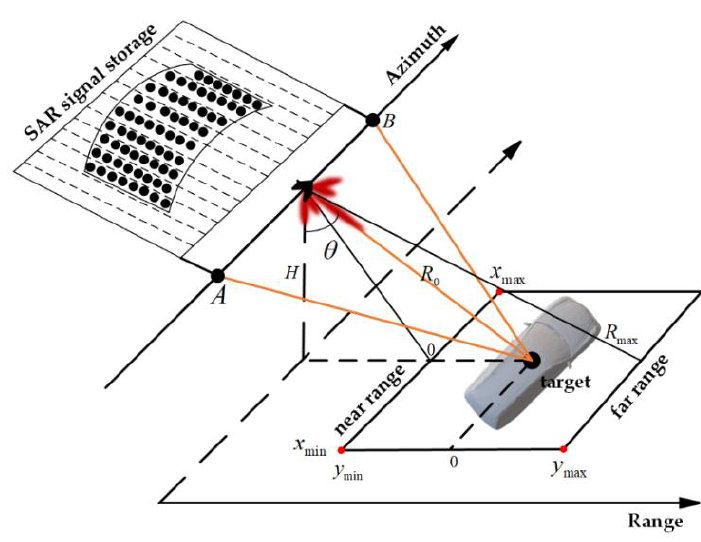
Figure 6. Echo time-domain simulation model.